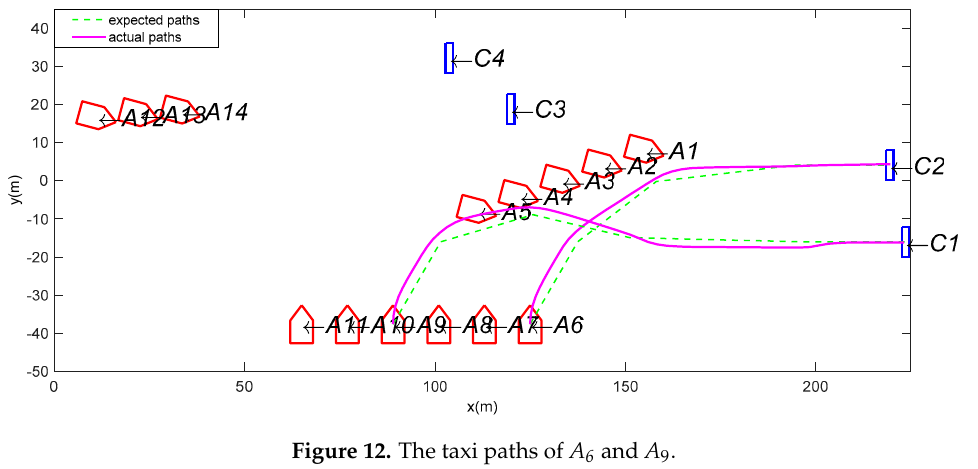
Figure 12. The taxi paths of A 6 and A 9 .